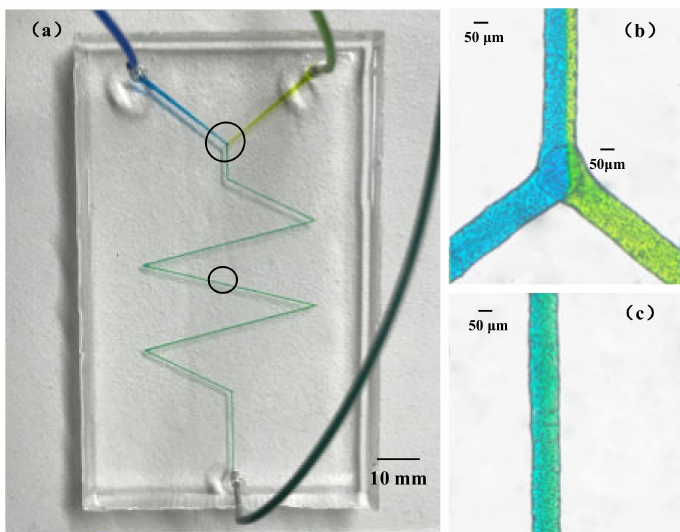
Figure 13. The zigzag microchannel: ( a ) mixing in the microchannel at a feeding speed of 10 µ L min − 1 ; ( b ) the mixed fluid at the junction; and ( c ) the mixed fluid near the outlet.